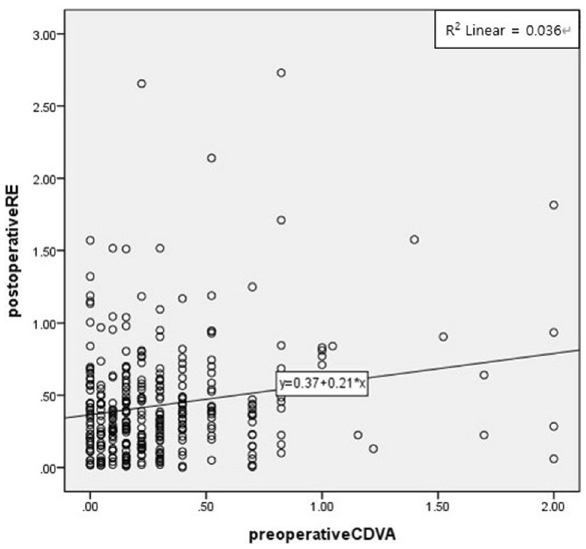
Figure 2. Relationship between corrected distance visual acuity and refractive error. RE, refractive error.